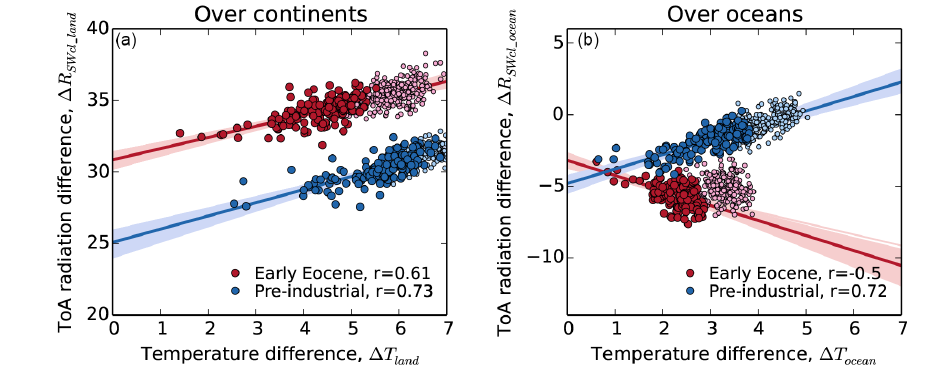
Figure 9. Evolution of the difference in TOA short-wave cloud radiative flux, R SWcl , with differences in near-surface temperature between the forest world and the bright desert world. The evolution of R SWcl is separated in the evolution above the continents (a) and above the oceans (b) . Global annual-mean values are considered. Red and blue points relate to the early Eocene climate and to the pre-industrial climate, respectively. Dark large points and bright small points show the first 150 years and the last 250 years, respectively. The regression and the correlation coefficient, r , consider the first 150 years. The shaded areas refer to the 95% confidence interval for the regression lines.